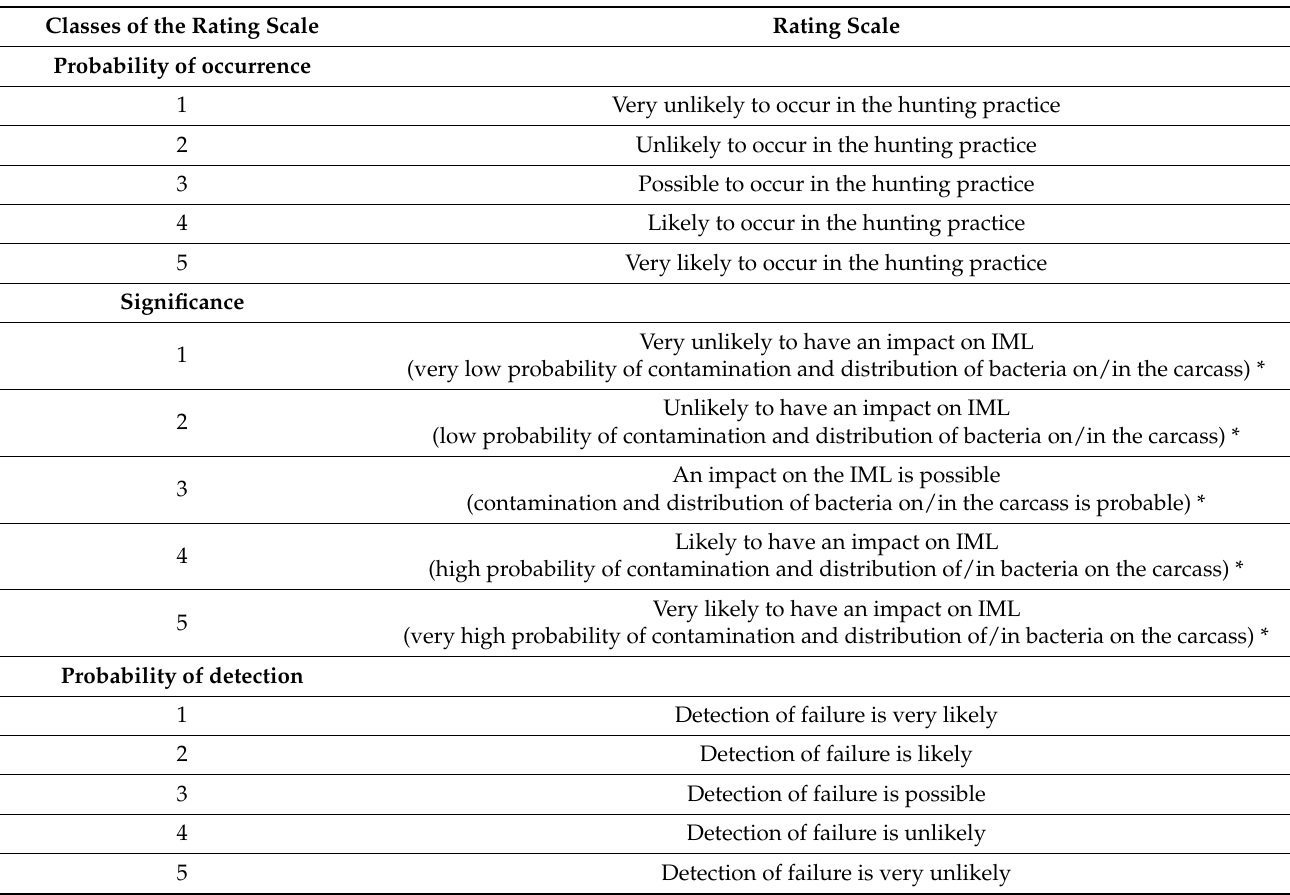
Figure 1. Flowchart for the investigated early steps of the hunting chain from observation of the living game animal to the sampling of the carcasses. Table 1. Rating scales used in Failure Mode and Effects Analysis (FMEA) to classify the probability of occurrence, significance and probability of detection to assess the impact of handling failures during the hunting chain on the initial microbial load (IML) of game